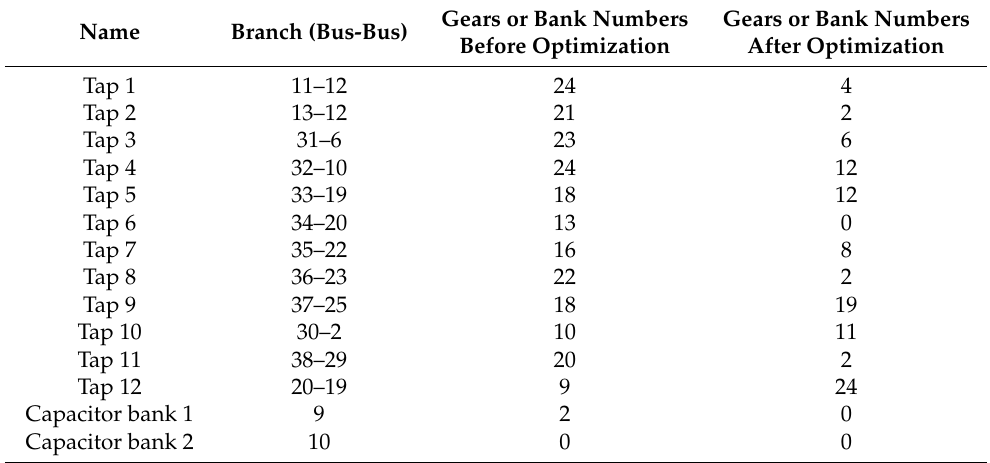
Table 7. Comparison of transformer tap gears and capacitor bank numbers before and after optimization.